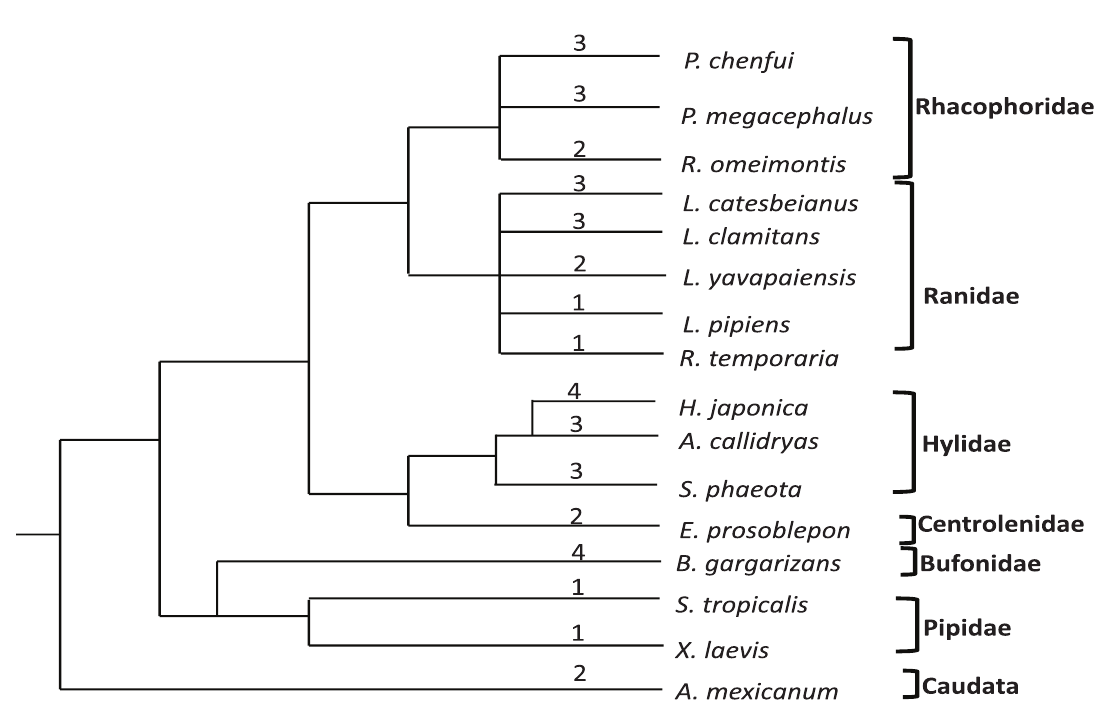
Figure 6. Numbers of putative MHC class Ia loci in amphibian species. The simplified phylogenetic tree of amphibian species with a deduced number of MHC class Ia loci based on the amphibian pedigree shown in Didinger et al., Zhao et al., and Roelants et al. The putative number of loci is shown above the corresponding